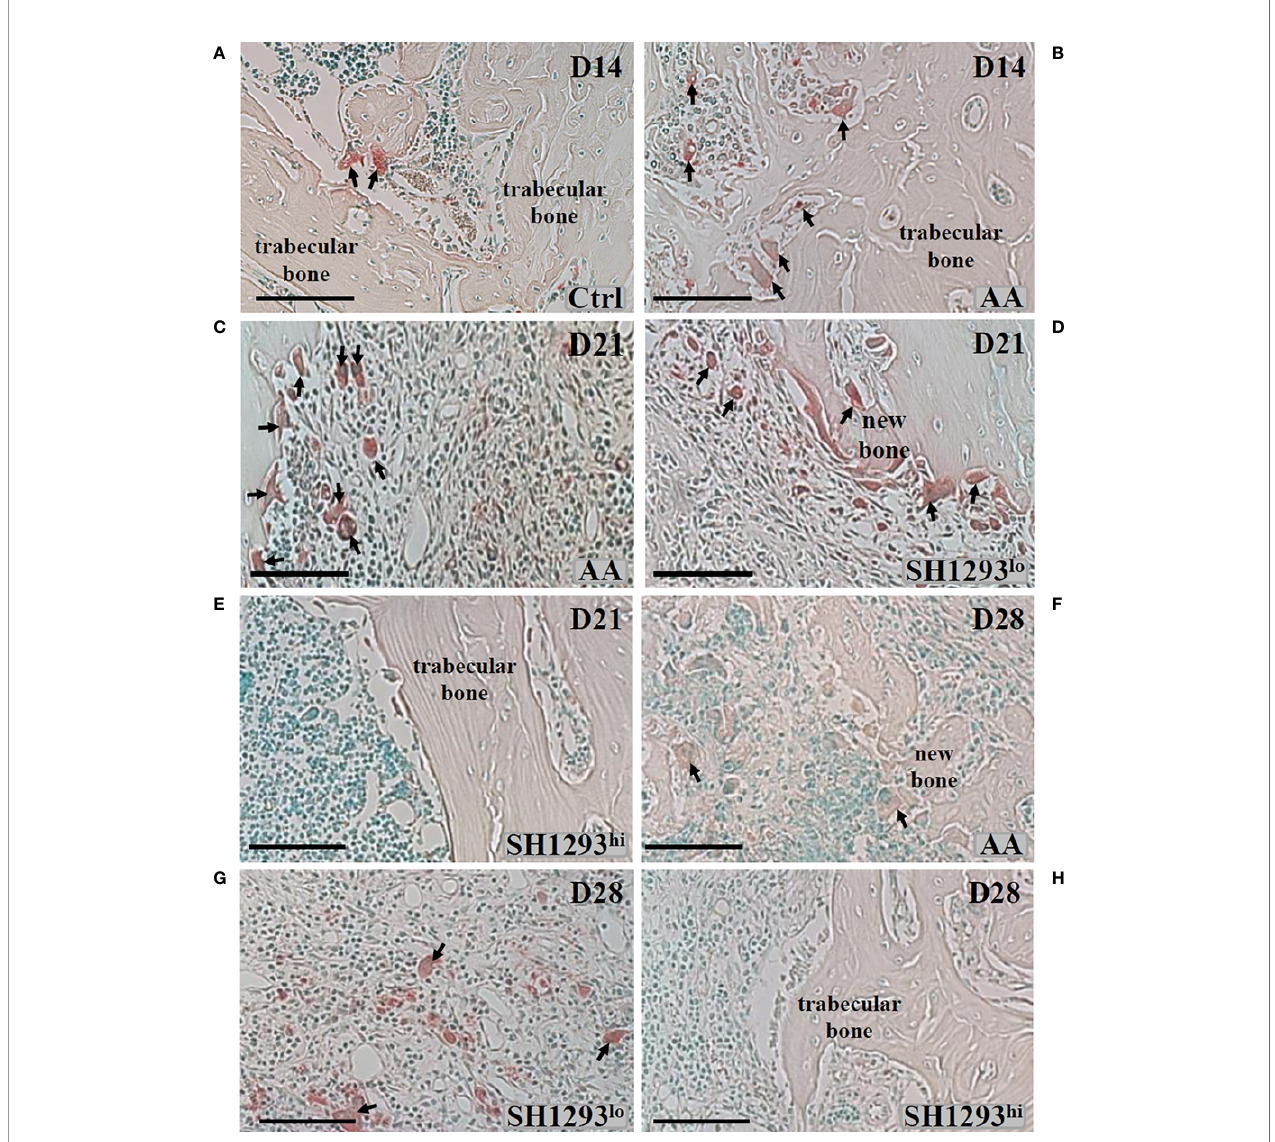
FIGURE 6 | SH1293 Minimizes Osteoclast Destruction of Trabecular Bone in High Responding-arthritic Rats by Reducing the Number of In fi ltrating Osteoclasts. Representative photomicrographs of TRAP-stained tissue sections from zone 2 (see Figure 7A ). (A) In Ctrl rats, osteoclast activity was minimal, a fi nding consistent with the normal appearance and abundance of trabecular bone in Ctrl rats on D14. Arrows indicate only two sites of osteoclast activity. (B) On D14, osteoclast activity was more apparent in AA rats, with more osteoclasts (arrows) present than observed in Ctrl rats, but trabecular bone appeared similar to that observed in Ctrl rats. (C) By D21, osteoclasts were abundant, and their increased presence consistent with severe trabecular bone resorption in AA rats (D, E) . In SH1293 rats, we observed SH1293 lo - and SH1293 hi -responding rats on D21, (D, E) , respectively. In low-responding SH1293 lo rats (D) , osteoclast presence and the resorption of trabecular bone was similar to that observed for vehicle-treated AA rats at this time point. In high-responding SH1293 hi rats (E) , the absence of osteoclasts and preservation of the trabecular bone was remarkable. (F) In AA rats on D28, osteoclasts were more numerous than at D21. Trabecular bone resorption was greater than that observed at previous time points and the deposition of new bone was observed in this treatment group. (G) On D28, in SH1293 lo rats, osteoclast numbers and trabecular bone loss were similar to that observed for AA rats. (H) In contrast, in SH1293 hi rats on D28, osteoclasts were not observed in trabecular bone and had remarkable sparing of trabecular bone. Calibration bar = 100 m